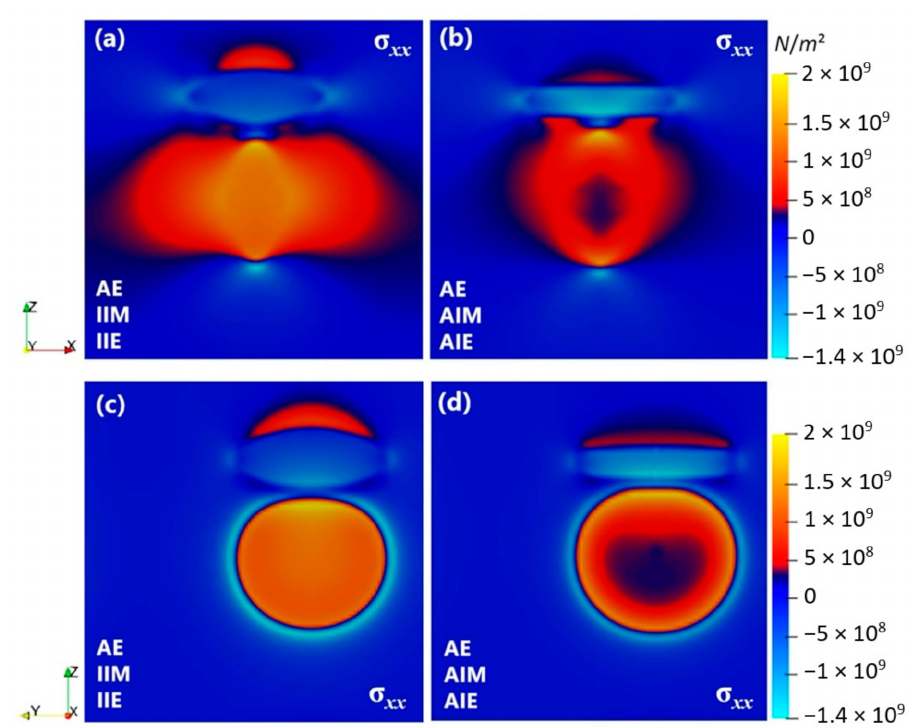
Figure 9. Two-dimensional-cross section of phase-field simulated stress ( σ xx ) profiles of two perpen- dicular precipitates with ( a , c ) AE, IIM and IIE conditions and ( b , d ) AE, AIM and AIE conditions in Al-1.69 at.% Cu alloy annealed at 453 K for t = 15,000 s, along different directions. Here a 100 × 100 × 100 domain with grid spacing of ∆ x = 0.7 is